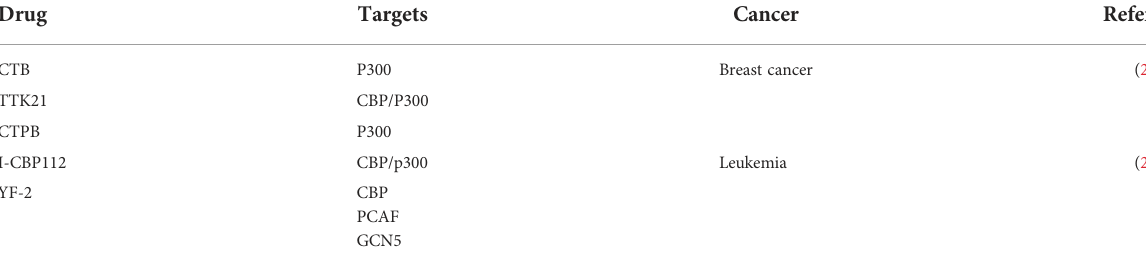
TABLE 4 Targets of HAT activators and associated